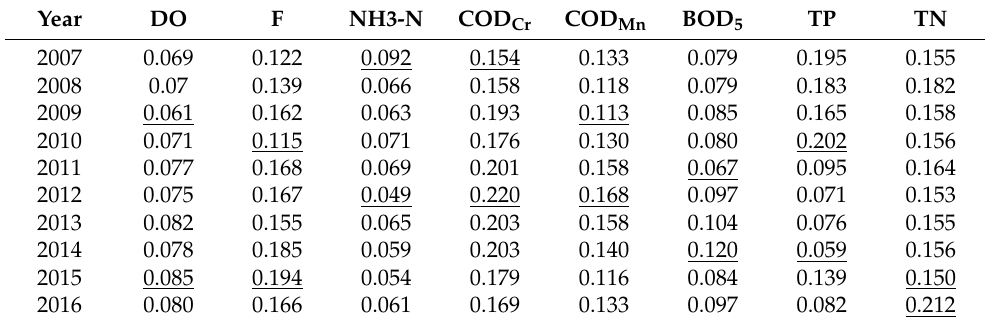
Table 4. Over-standard weight values.